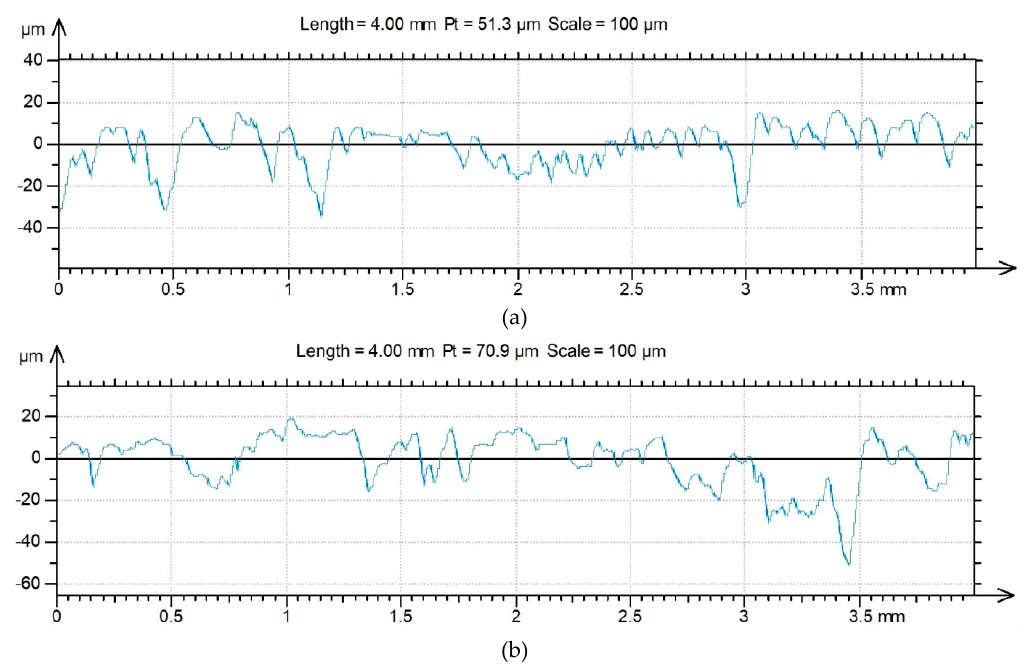
Figure 20. 2D profile of the fractured surface of the rigid adherend in a variant of FML with adhesive